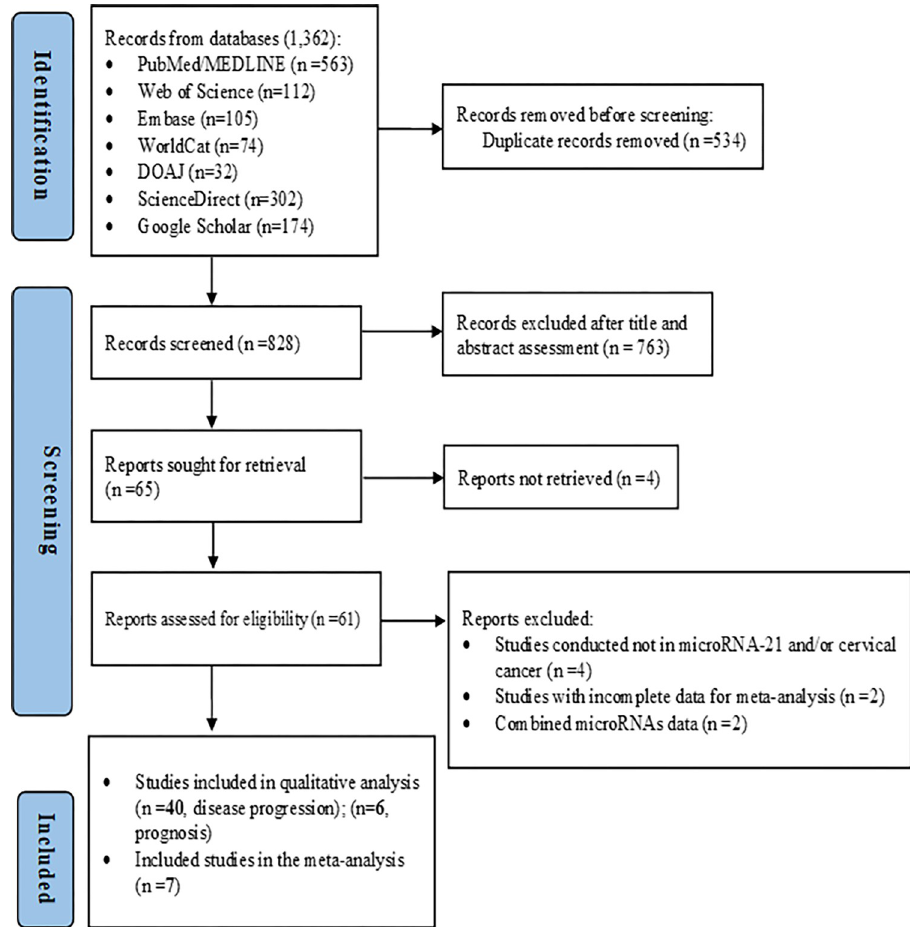
Fig 1. PRISMA 2020 flow diagram summarising the selection process of studies in the systematic review and meta-analysis.